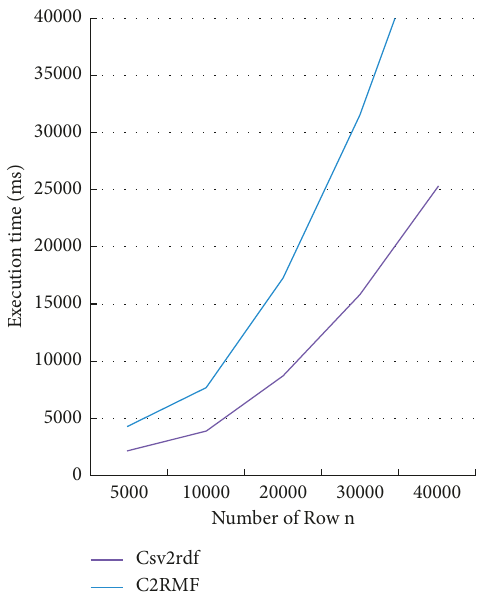
Figure 8: Comparison of the execution time by C2RMF algorithm and csv2rdf based on different number of